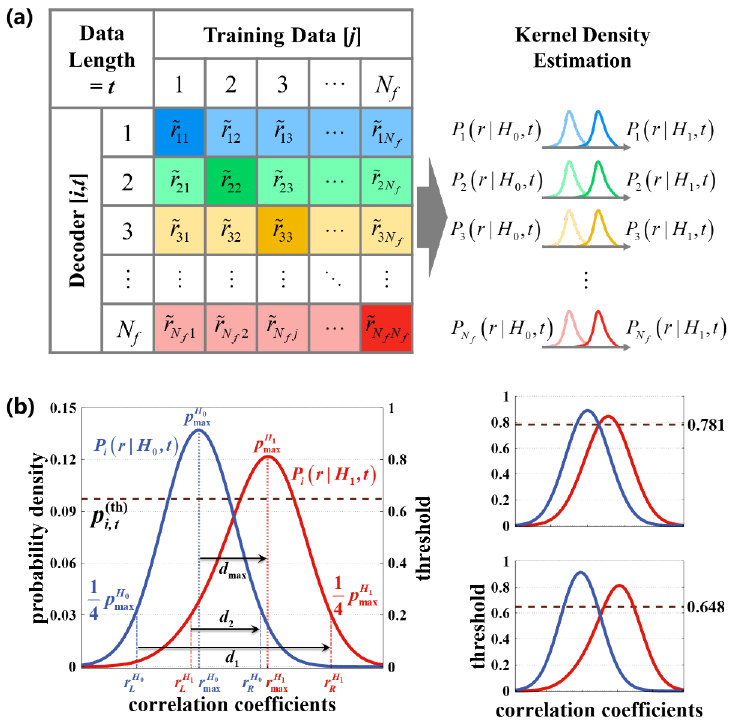
Figure 4. Key process of constructing a model for dynamic stopping: ( a ) the estimation of probability density functions for each target, and ( b ) the method to calculate the adaptive thresholds.